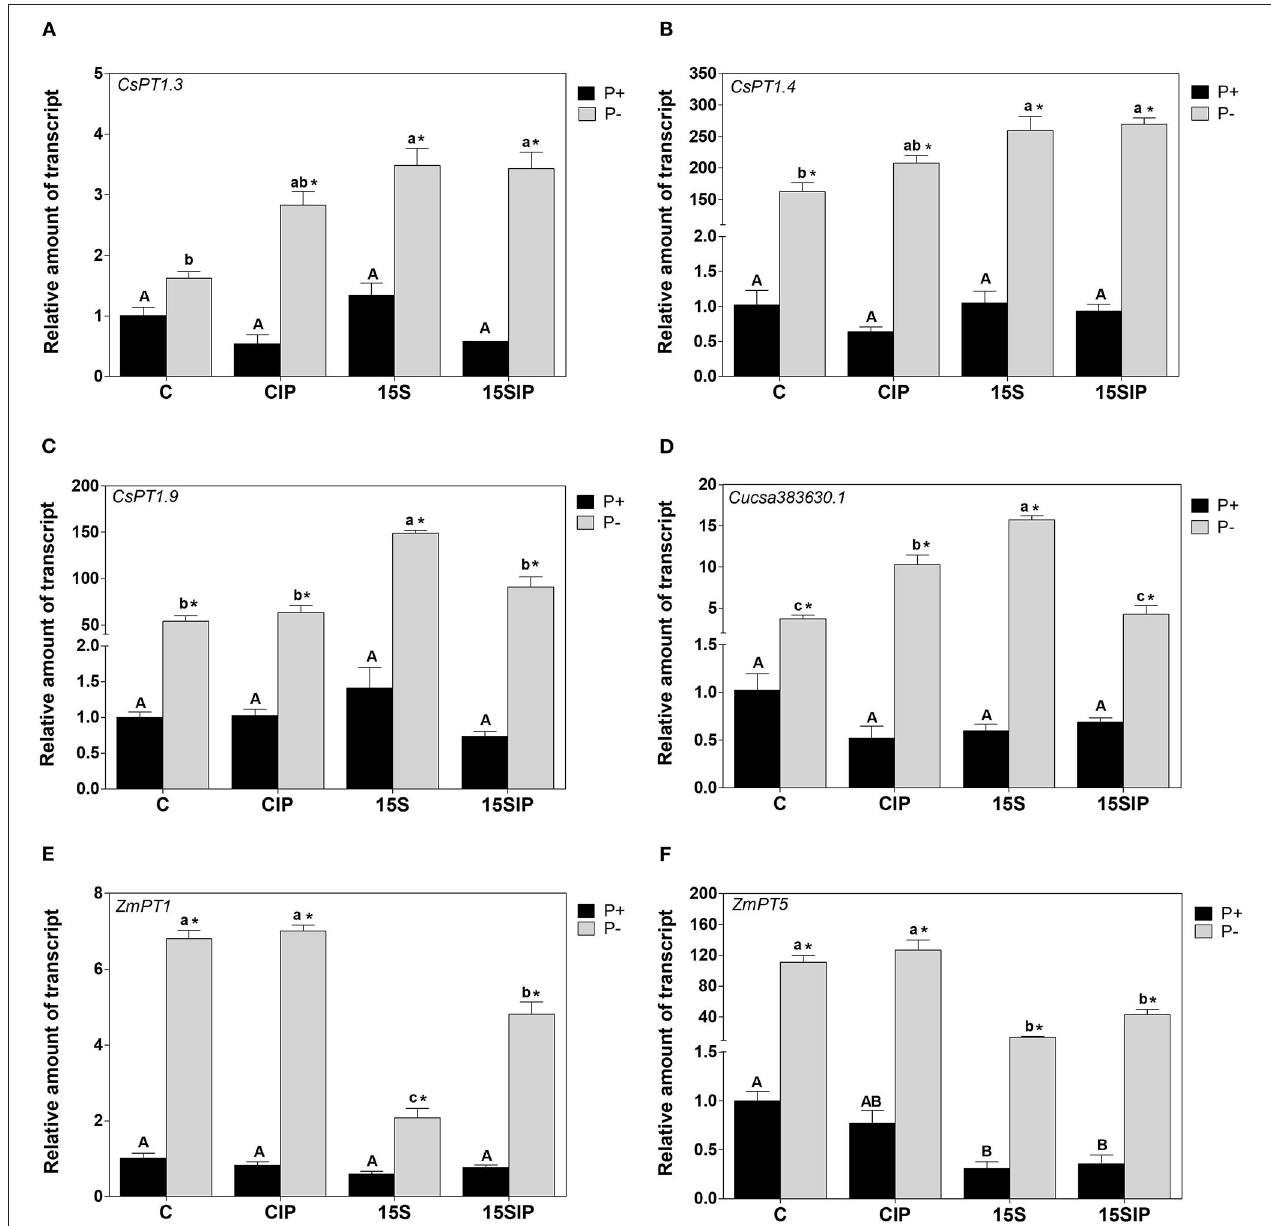
FIGURE 5 | Gene expression analysis of (A) CsPT1.3 , (B) CsPT1.4 , (C) CsPT1.9, and (D) Cusca383630.1 in the roots of the cucumbers, and (E) ZmPT1 and (F) ZmPT5 in the roots of maize grown hydroponically under different P-fertilization levels (P + and P–) and different biostimulant treatments with Enterobacter 15S (C, CIP, 15S, 15SIP). The expression level of each gene was normalized to the expression level of the elongation factor isoform 1-alpha (EF-1 α ). The relative expression ratios were calculated using the uninoculated control under complete P (P + : C) as a calibrator sample. Values are means ± SE; n = 3. Uppercase letters compare treatments under P + and lowercase letters compare treatments under P–. An asterisk is present when there is a difference in the same treatment between P + and P–. Equal letters correspond to average values that do not differ according to Tukey’s test ( p <